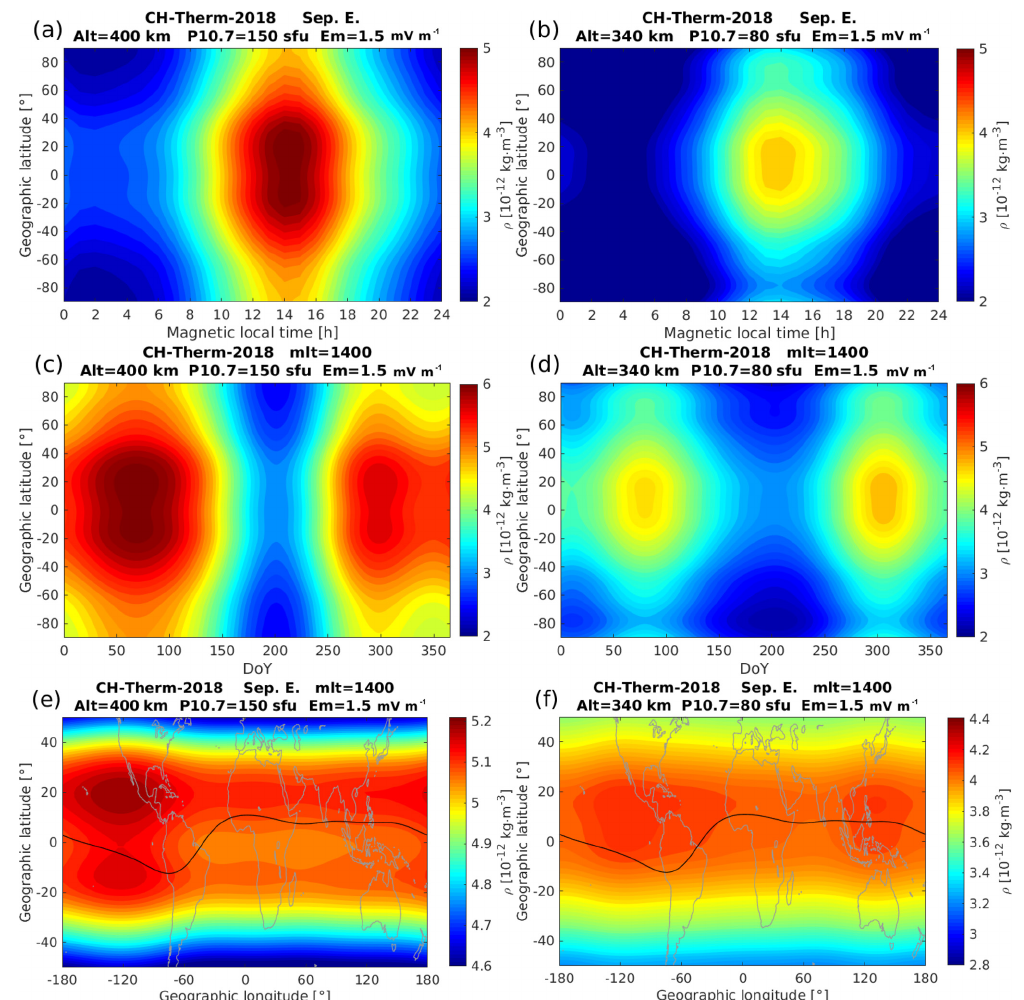
Figure 4. Similar as Fig. 3, but for the distribution of (a) and (b) : geographic latitude versus magnetic local time; (c) and (d) : geographic latitude versus day of year; (e) and (f) : geographic latitude versus